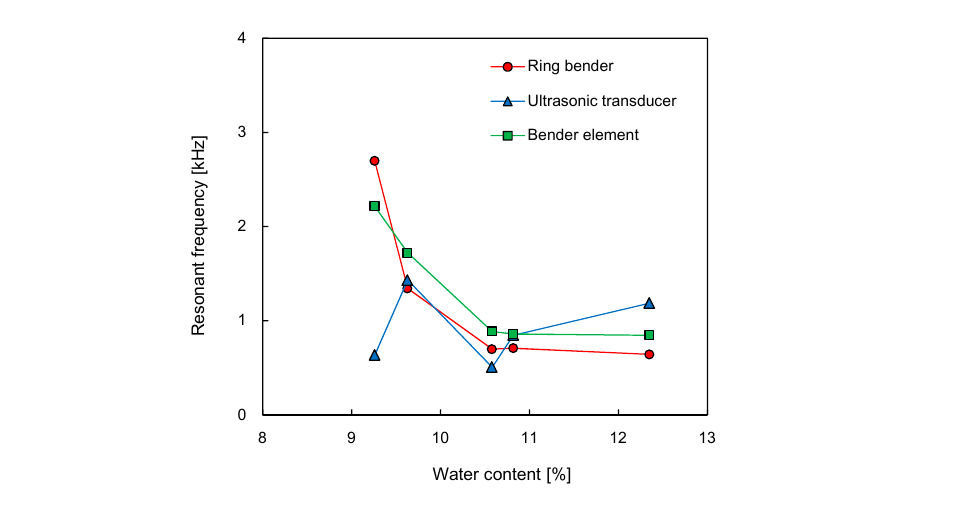
Figure 9. Variation in the resonant frequency of shear waves estimated from the three different sensors. The resonant frequencies obtained from the RB were compared with those obtained from the UT and BE, as shown in Figure 10. The slope and the coefficient of determination of the linear relationship between the resonant frequencies of the RB and the BE were 0.995 and 0.845, respectively, when the y-intercept of the linear relationship corresponded to zero. For the linear relationship between the resonant frequencies of the RB and the UT, the linear trend line showed a negative slope and a value close to zero of the coefficient of determination. At the water content of 9.3%, the difference in resonant frequencies between the RB and the UT was significant. Thus, the data point in Figure 10 was far from the line of equality. In short, any meaningful relationship between the resonant frequencies of the RB and the UT could not be established due to the scattered data.